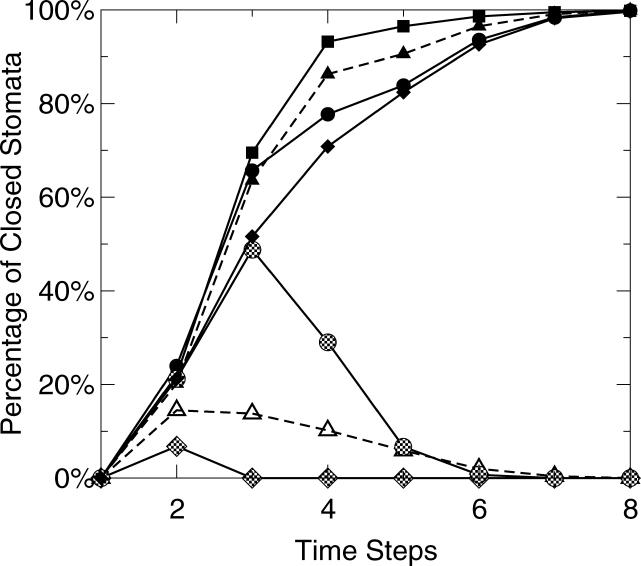
Summary of the Dynamic Effects of Calcium DisruptionsAll curves represent the probability of ABA-induced closure (i.e., the percentage of simulations that attain closure) as a function of time steps. Black triangles with dashed line represent the normal (wild-type) response to ABA stimulus; open triangles with dashed lines show how the probability of closure decays in the absence of ABA. CIS + PA double mutants (dashed circles) and Ca2+
c + pHc double mutants (dashed diamonds) show insensitivity to ABA. Ca2+ ATPase + RCN1 double mutants (black circles) show hyposensitive (delayed) response to ABA. Guanyl cyclase + CIS + CaIM triple mutants (black diamonds) also show hyposensitivity; note that none of the guanyl cyclase or CIS or CaIM single knockouts show changed sensitivity (data not shown). Ca2+ ATPase mutants (black squares) show faster than wild-type ABA-induced closure (ABA hypersensitivity).